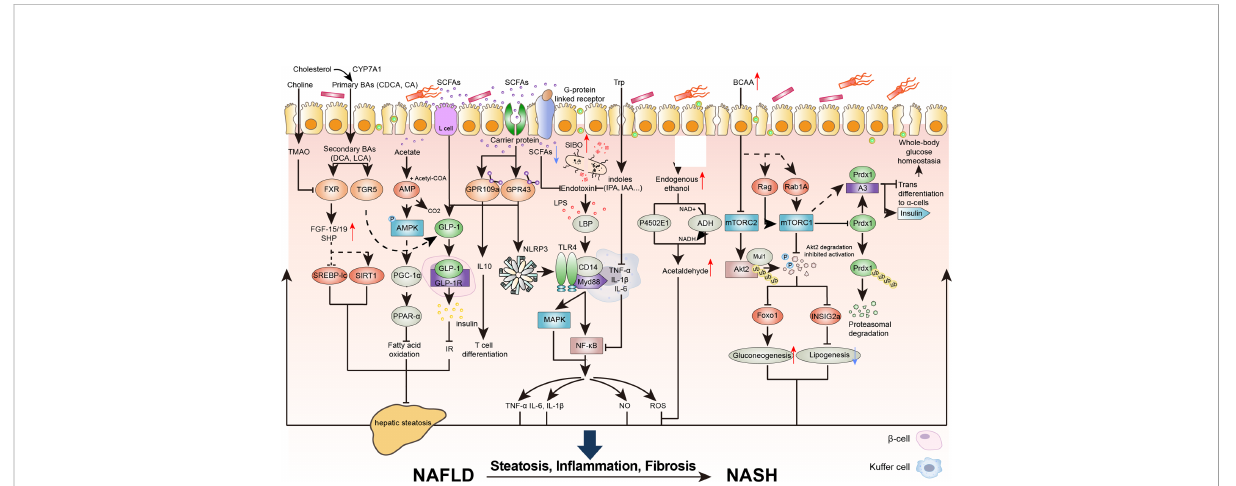
FIGURE 2 The destruction of the intestinal epithelial barrier caused by intestinal fl ora imbalance is an important condition for the development of NAFLD and nonalcoholic steatohepatitis (NASH). Intestinal in fl ammation and the production of metabolic toxins cause intestinal barrier dysfunction, exposing the liver to fl ora metabolites and promoting the development of NAFLD. BAs, bile acids; CDCA, chenodeoxycholic acid; CA, cholic acid; DCA, deoxycholic acid; LCA, lithocholic acid; TMAO, trimethylamine oxide; TGR5, Takeda G protein-coupled receptor 5; FGF, fi broblast growth factor; SHP, small heterodimer partner; SREBP-lc, sterol regulatory element-binding protein-lc; SIRT1, sirtuin 1; PGC-1a, proliferator activated receptor g coactivator 1 a; PPARa, peroxisome proliferator activated receptor alpha; GLP, glucagon like peptide; GPR, G protein- coupled receptor; TNF, tumor necrosis factor; IL-6, interleukin; NLRP3, NOD-like receptor protein 3; LPS, lipopolysaccharide; LBP, lipopolysaccharidebinding protein; SIBO, Small intestinal bacterial overgrowth; IPA, Indole-3-propionic acid; IAA, 3-Indoleacetic acid; Myd88, myeloid differentiation factor 88; MAPK, mitogen-activated protein kinase; NF-kB, nuclear factor kappa-B; NO, nitric oxide; ROS, reactive oxygen species; Trp, tryptophan; NAD, nicotinamide adenine dinucleotide; BCAA, branched-chain amino acid; mTORC, mammalian target of rapamycin complex; Akt, protein kinase B; INSIG2a, insulin induced gene 2a; Foxo1, forkhead box O1; Mul1, mitochondrial E3 ubiquitin protein ligase 1; RAB1A, member ras oncogene family; Prdx1, peroxiredoxin 1; Ub, ubiquitin; p-,